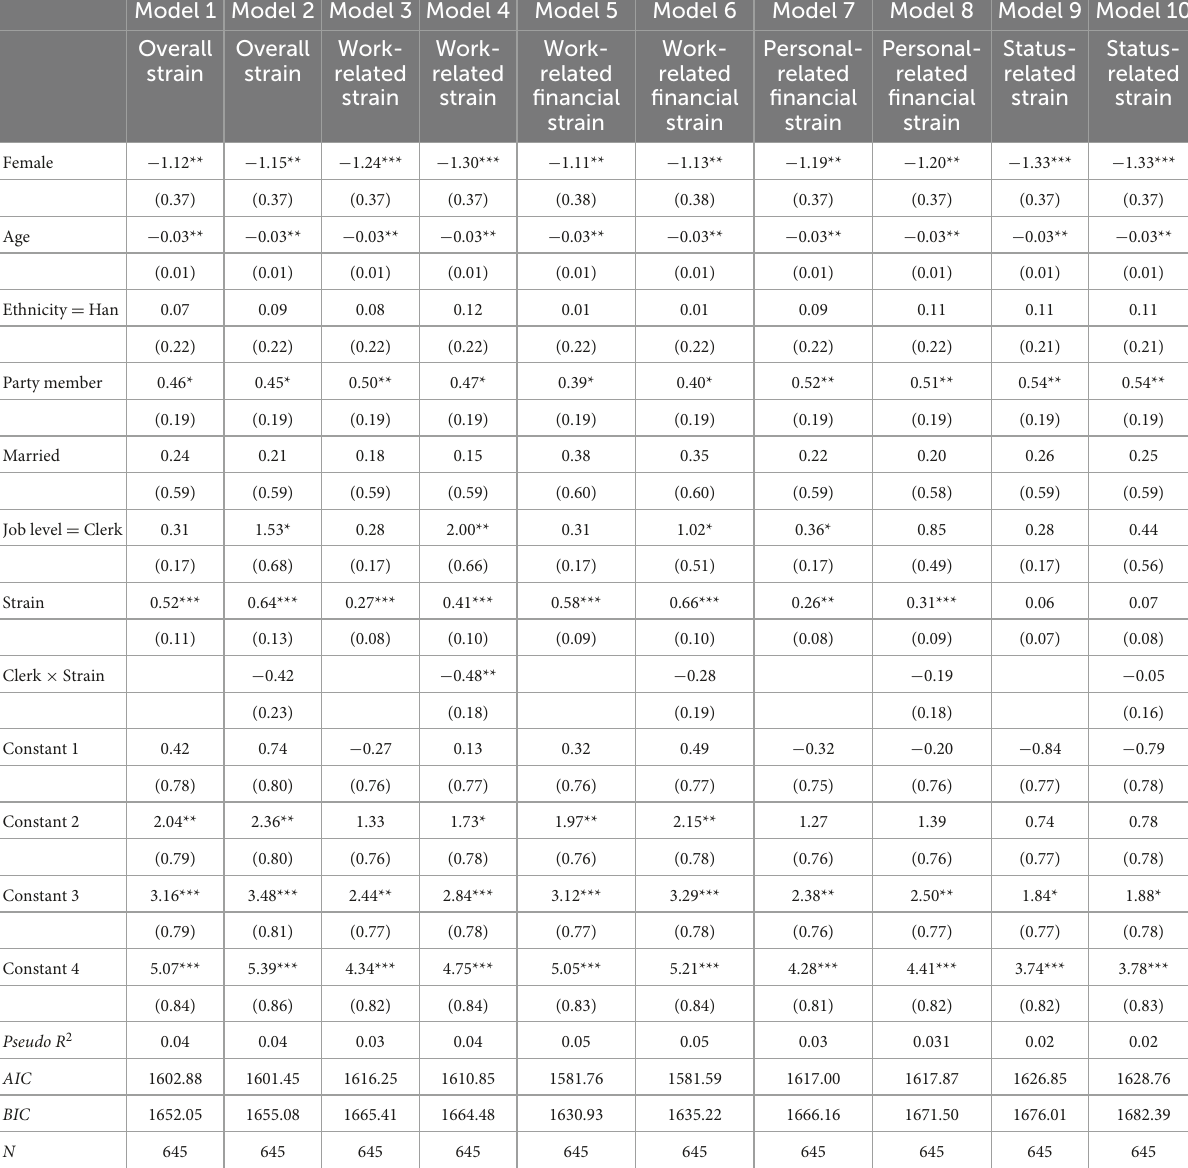
TABLE 3 Ordered logistic regression